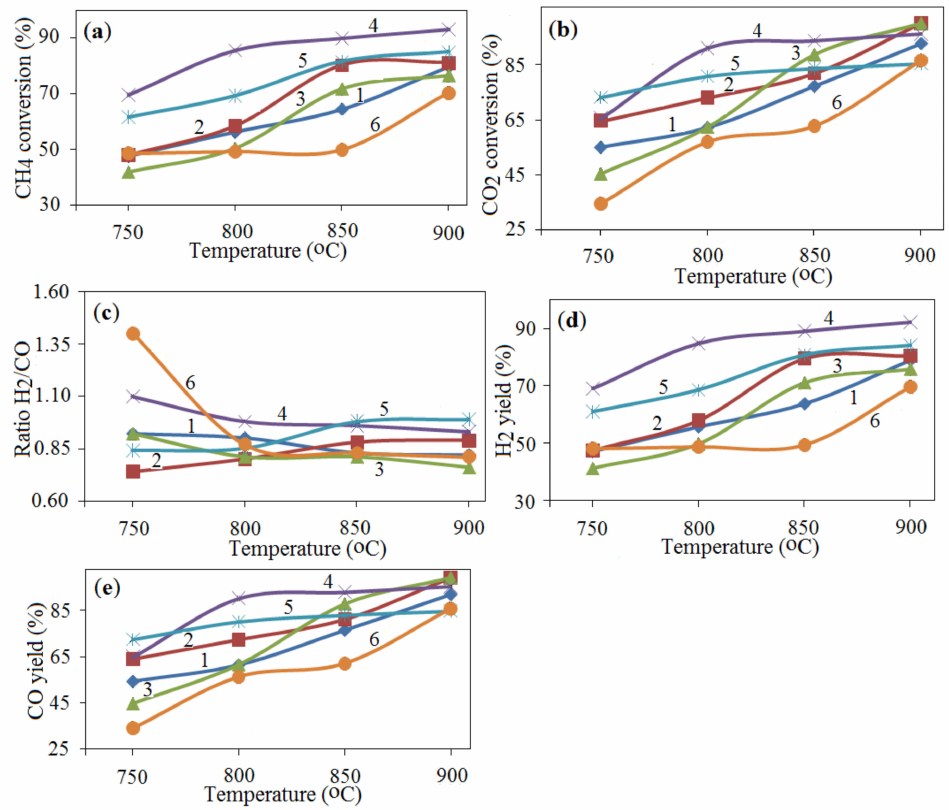
Figure 12. Dry reforming of methane on NiO–Al-Al 2 O 3 catalysts with different ratios of